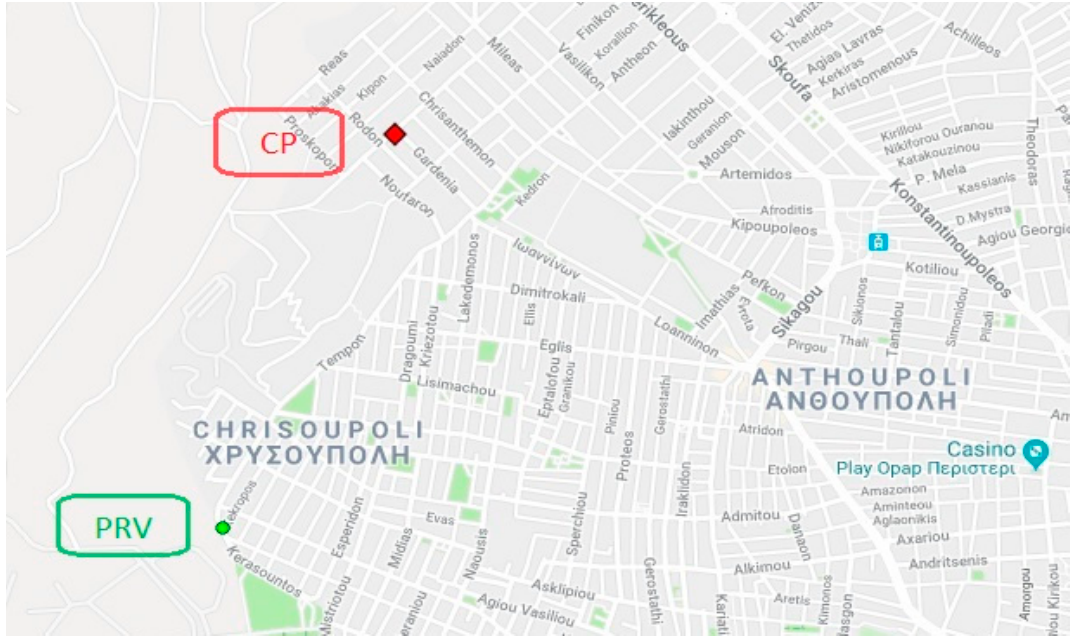
Figure 3. Map of the PRV site and Critical Point